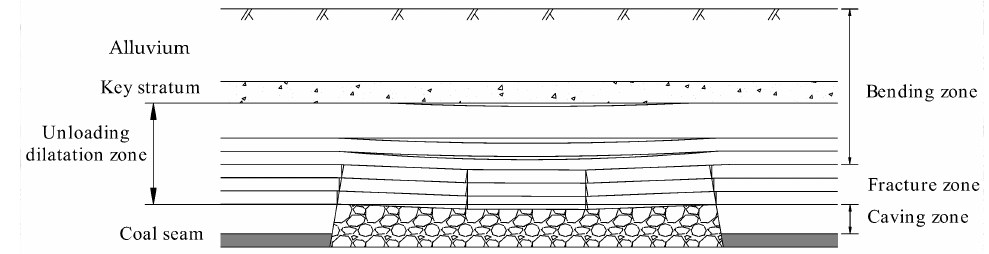
Figure 1. Diagram of three zones